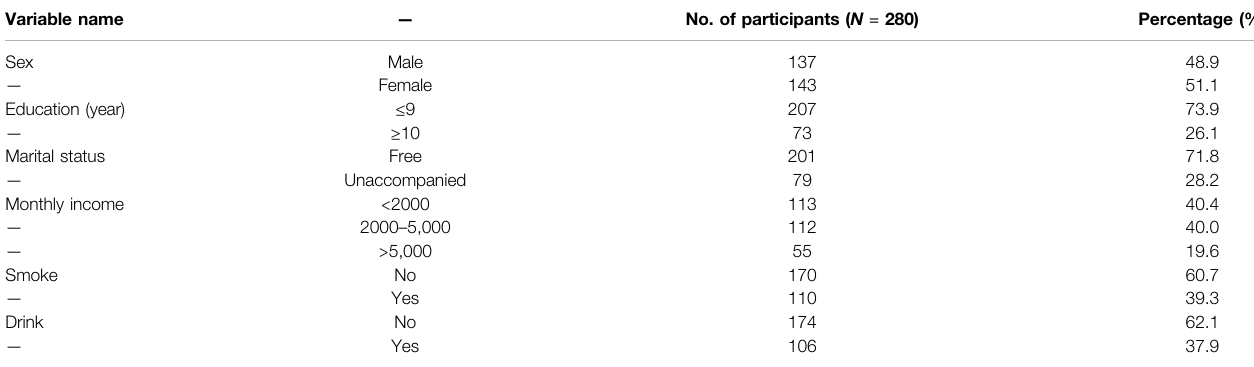
TABLE 1 | | Characteristics of inpatients with CHD ( N (cid:1) 280).